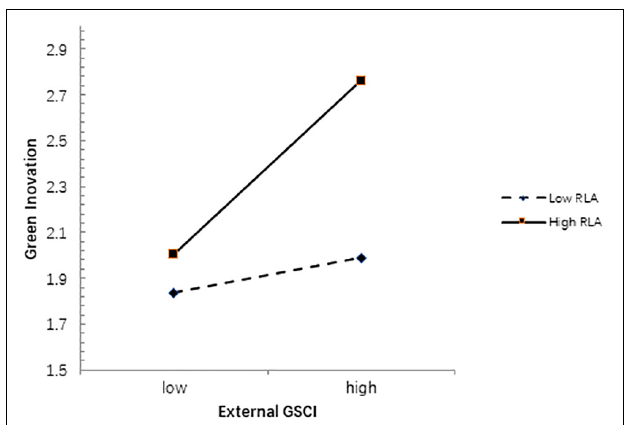
FIGURE 2 | Moderating effect of RLA.